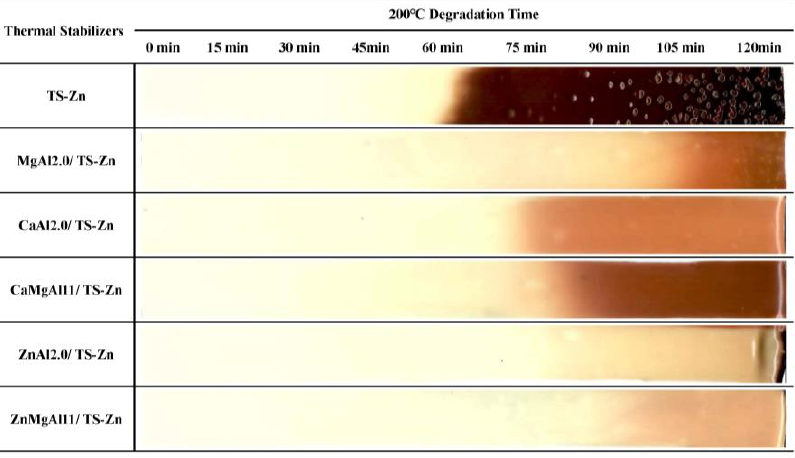
Figure 5. XRD patterns of LDHs with Mg/Al molar ratios of 2.0, 2.5, 3.0, and 3.5.